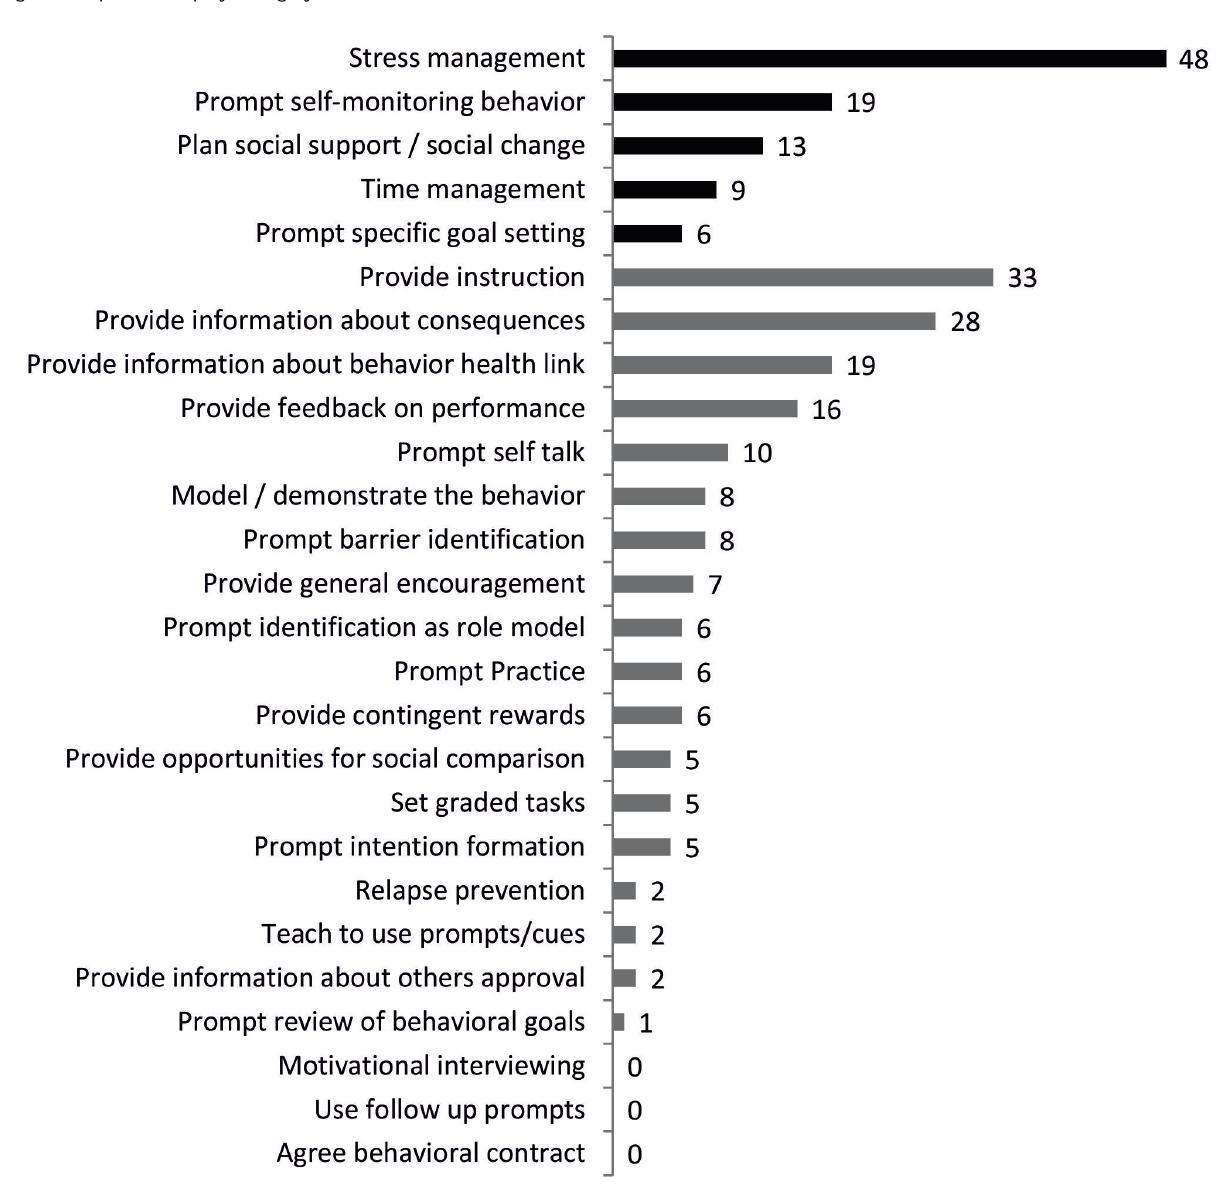
Figure 2. Behavior change techniques. Absolute frequencies of the 26 behavior change techniques used in the 62 apps, ranked by the most frequently applied techniques. Scoring followed the taxonomy of Abraham and Michie. Coping-relevant techniques are displayed in black and unspecific behavior change techniques are displayed in